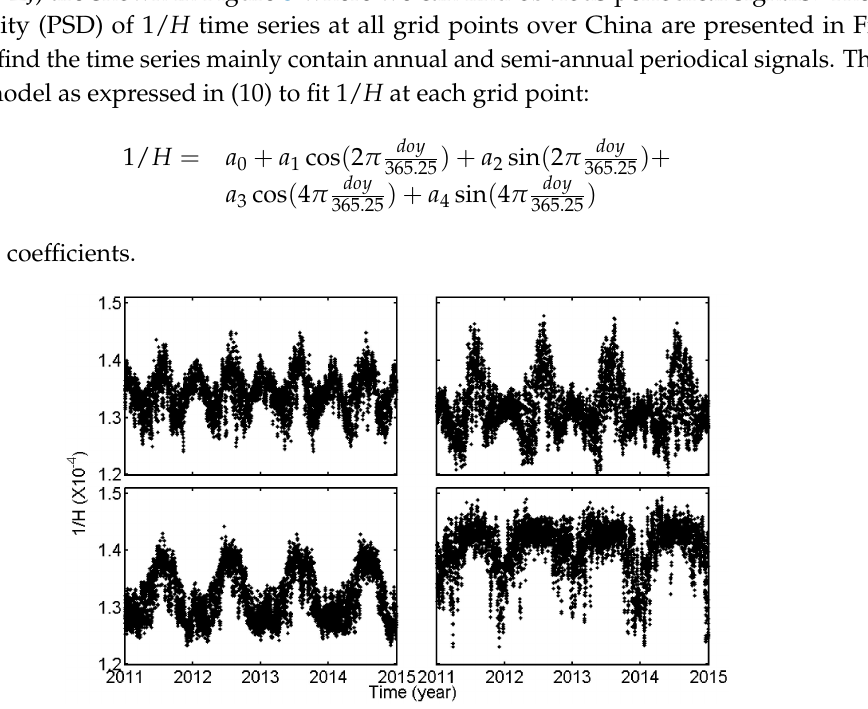
Figure 3. The 4-year (2011~2014) time series of parameter 1/ H at the nearest grid points of four GPS